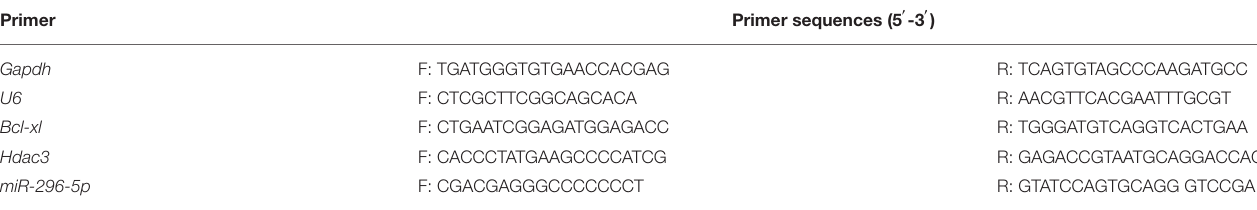
TABLE 1 | Primer sequences used in RT-qPCR analysis.